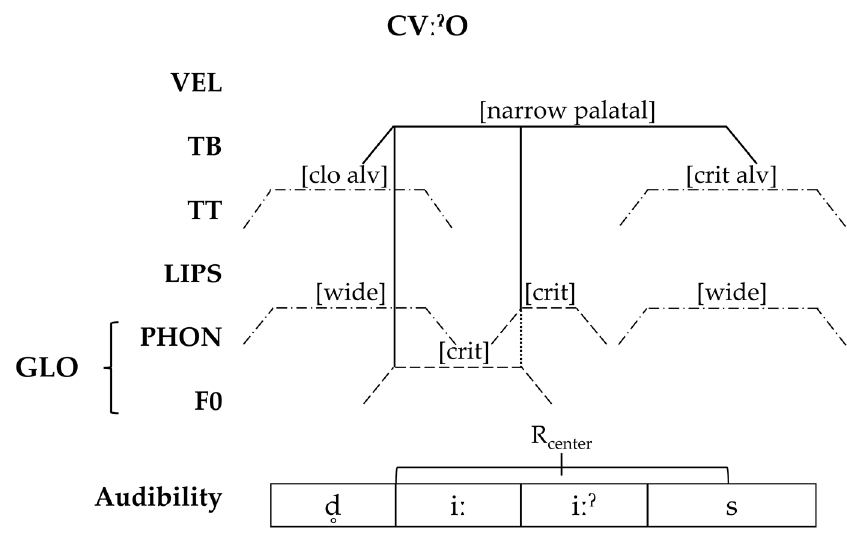
Figure 15. The phonetic realization of stød onset in CV ːˀ O words, such as [ d̥ i ːˀ s] ‘fog.’ Note that stød begins early relative to the sonorant rhyme center, possibly for perceptual